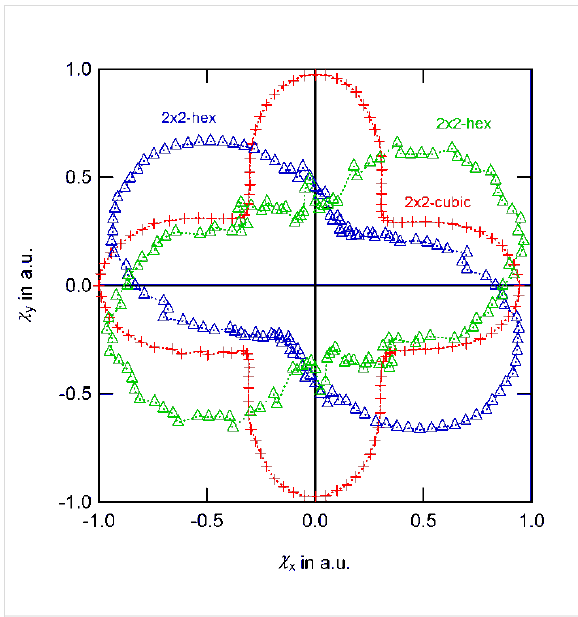
Figure 18: Direction dependent responses of different small particle assemblies to an external magnetic field. 2 × 2-grids align their magnetic moments in vortex-like states as shown in Figure 16. For cubic symmetry, the susceptibility is “degenerated” and independent of the vortex orientation. For hexagonal grids clock- and counter clock- wise orientation entail different